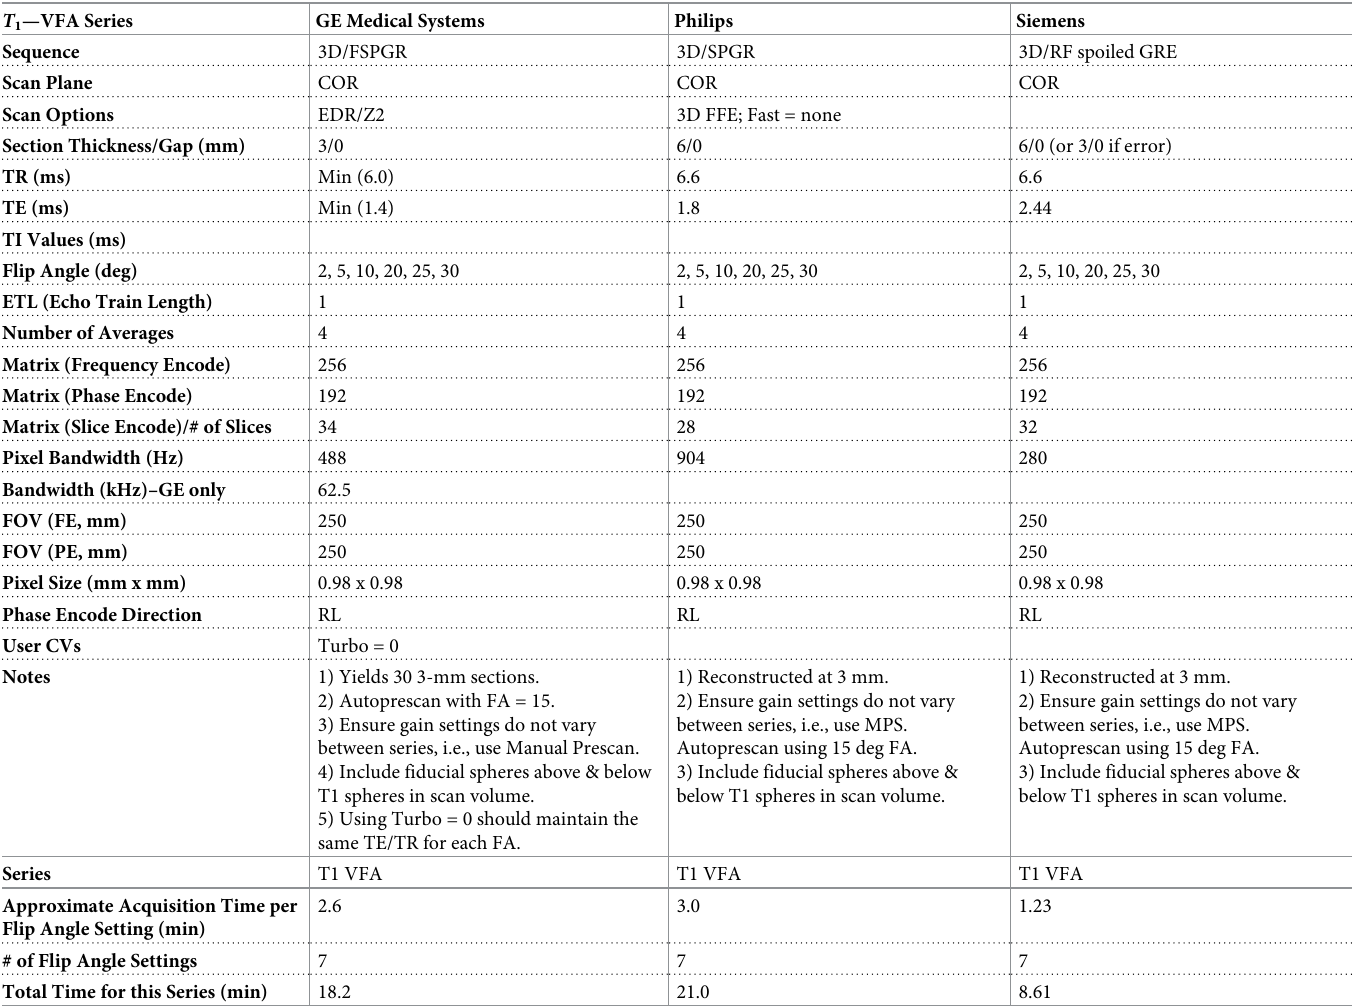
Table 3. Variable flip angle (VFA) measurement